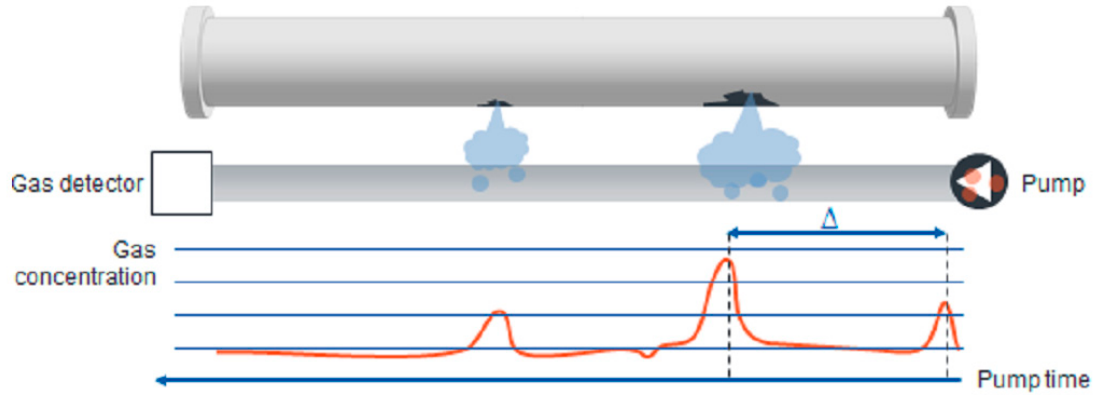
Figure 4. Sensor hose system for pipeline leakage detection [2].